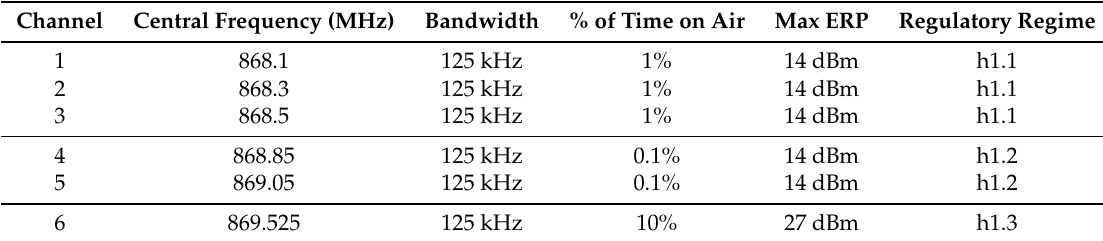
Table 5. LoRaWAN default channels and duty cycle